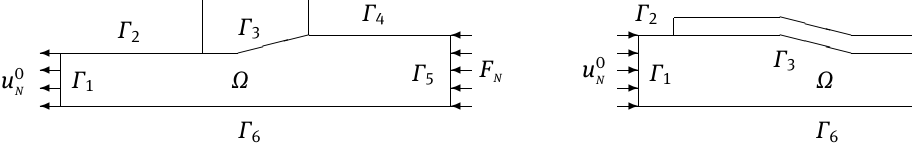
Fig. 1. Illustration of strip drawing and extrusion